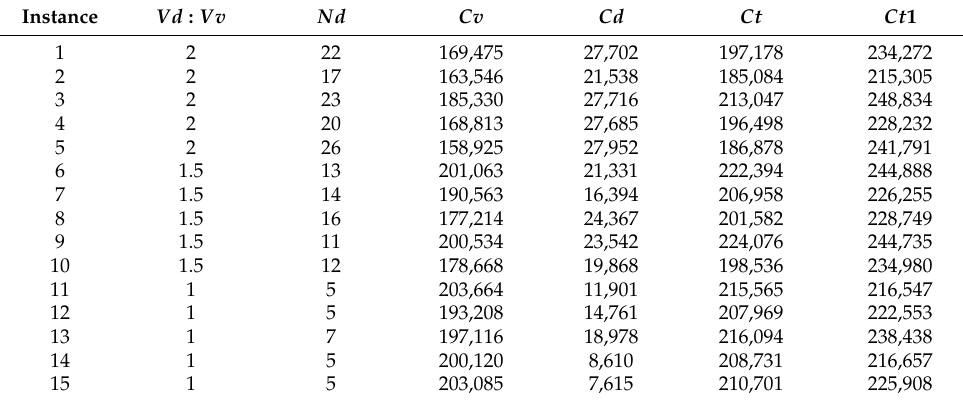
Table 7. Impact of drone versus road vehicle